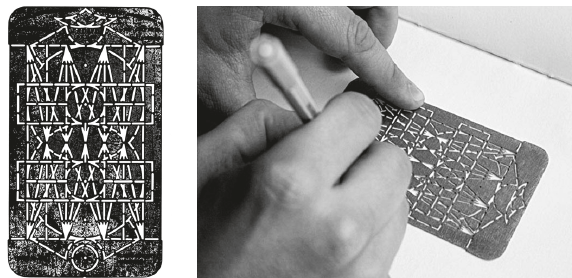
Figure 2: Plaque D´ecoup´ee Universelle , Joseph A. David,